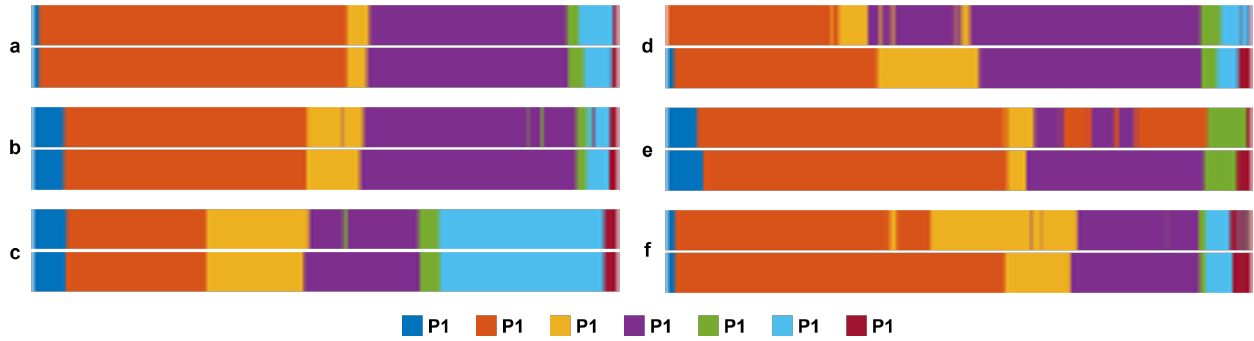
Figure 5. Visualization of localization maps of the CNN_MMC and CNN_SE_MF approaches for the seven surgical tools. For each tool, the manually labeled and predicted bounding boxes are visualized in green and blue, respectively. Images are labeled with the IoU (%) between the predicted and manually labeled boxes.